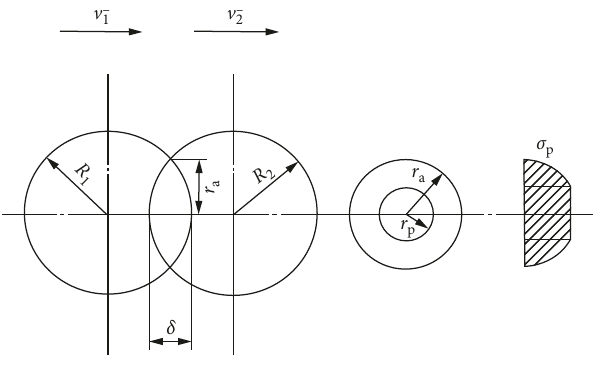
Figure 1: Diagram of two-ball